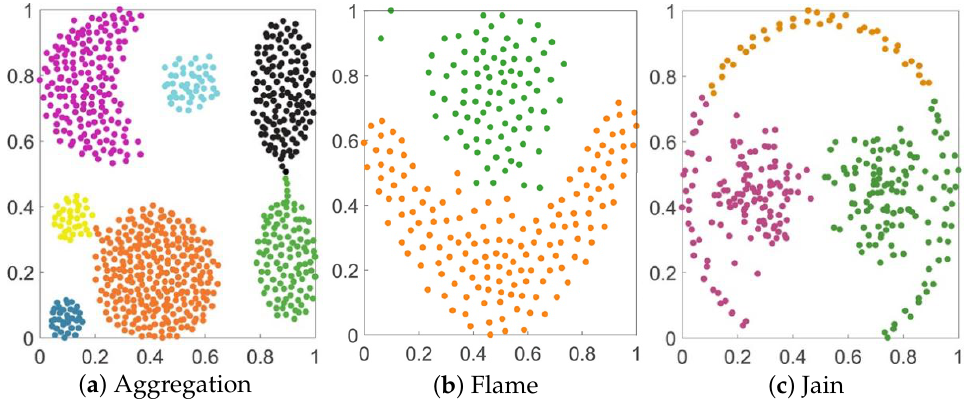
Figure 4. Clustering effect of the KNN-DPC algorithm on Aggregation, Flame and Jain.